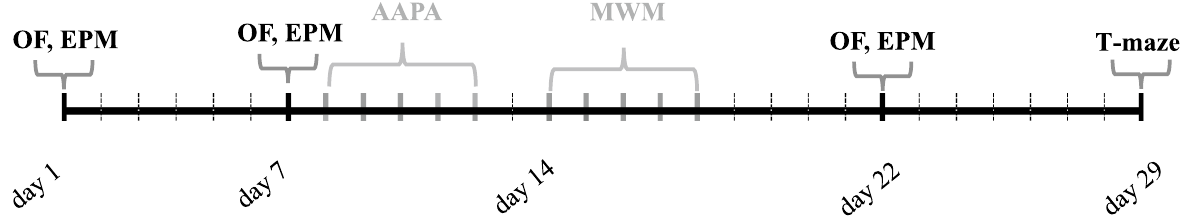
Figure 1. A time axis illustrating the experimental design of this study. Each point on the axis represents one day, bold points represent testing days, dotted points represent days with no experiments. OF—Open field test, EPM—Elevated plus maze test, T-maze—modified T-maze test. Cognitive tasks are shown in grey: AAPA— Active Allothetic Place Avoidance task 43 , MWM—Morris Water Maze task 44